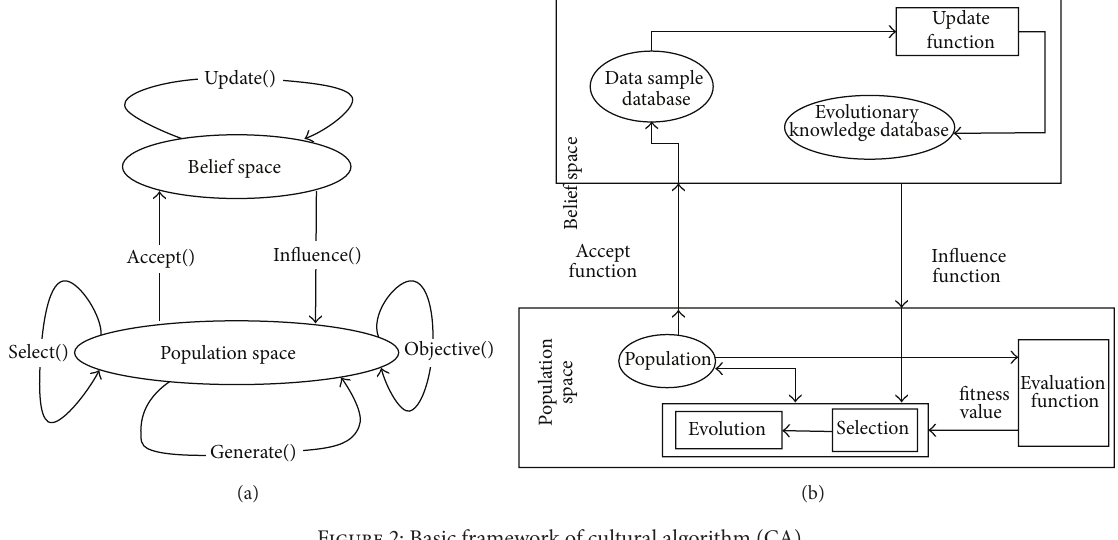
Figure 2: Basic framework of cultural algorithm